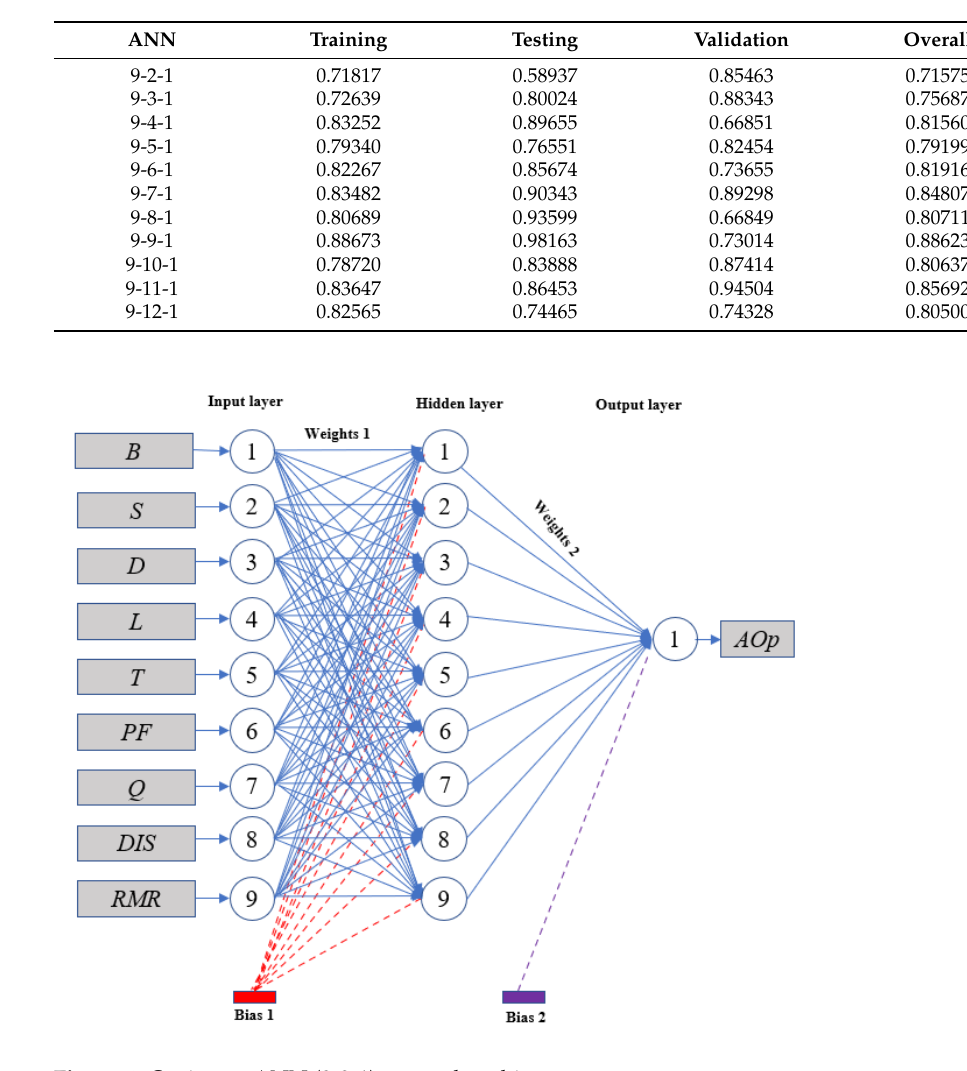
Figure 4. Optimum ANN (9-9-1) network